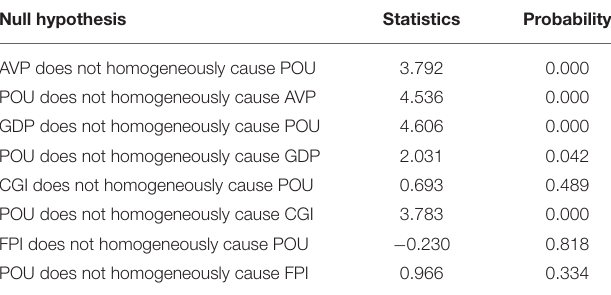
TABLE 10 | Results of heterogeneous panel causality